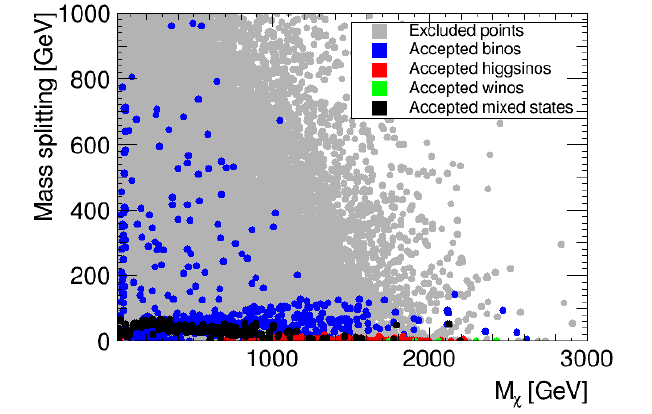
Figure 6 . Points respecting both sides of the Planck 2015 relic dark matter density measurement in the mass splitting between the neutralino and the next lightest supersymmetric particle and the neutralino mass parameter plane.